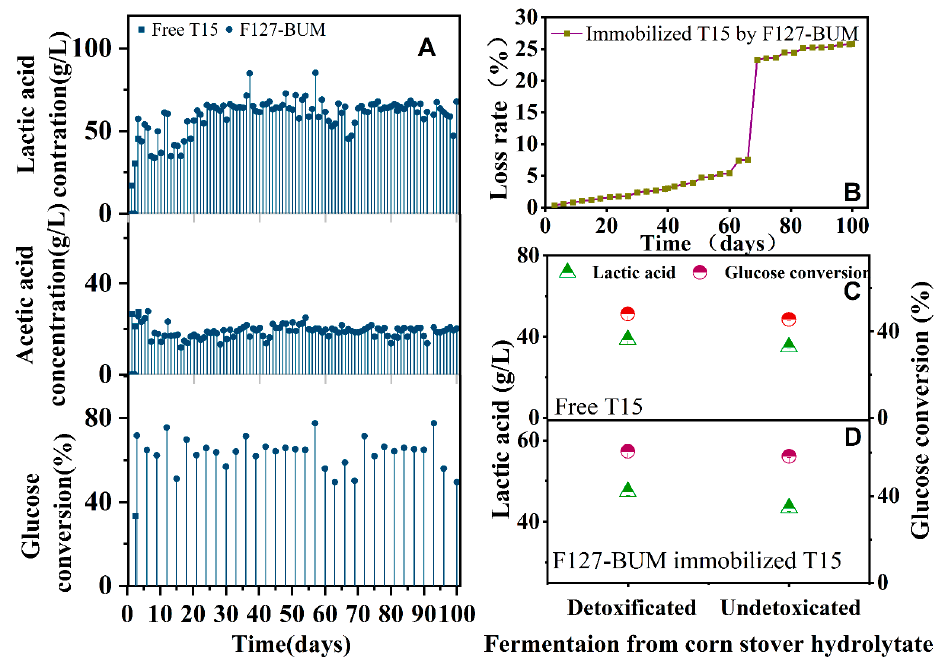
Figure 4. ( A ) Yield analysis of D-LA and its by-product acetic acid obtained from the simultaneous extreme fermentation of free-living bacteria, F127-BUM microencapsulated colloids. Activation of the product after 30 d of liquid nitrogen cryopreservation after 70 d and cyclic fermentation for 30 d again to confirm the yield analysis of the activated product ( B ) Comparison of the wear rate of F127-BUM microencapsulated colloids during the extreme fermentation. Corn stover hydrolysate was selected as the sole carbon source for D-LA production. LA production by immobilized LA microencapsulated colloids ( C ): non-hydrolysis detoxification treatment ( D ): hydrolysis detoxification treatment.